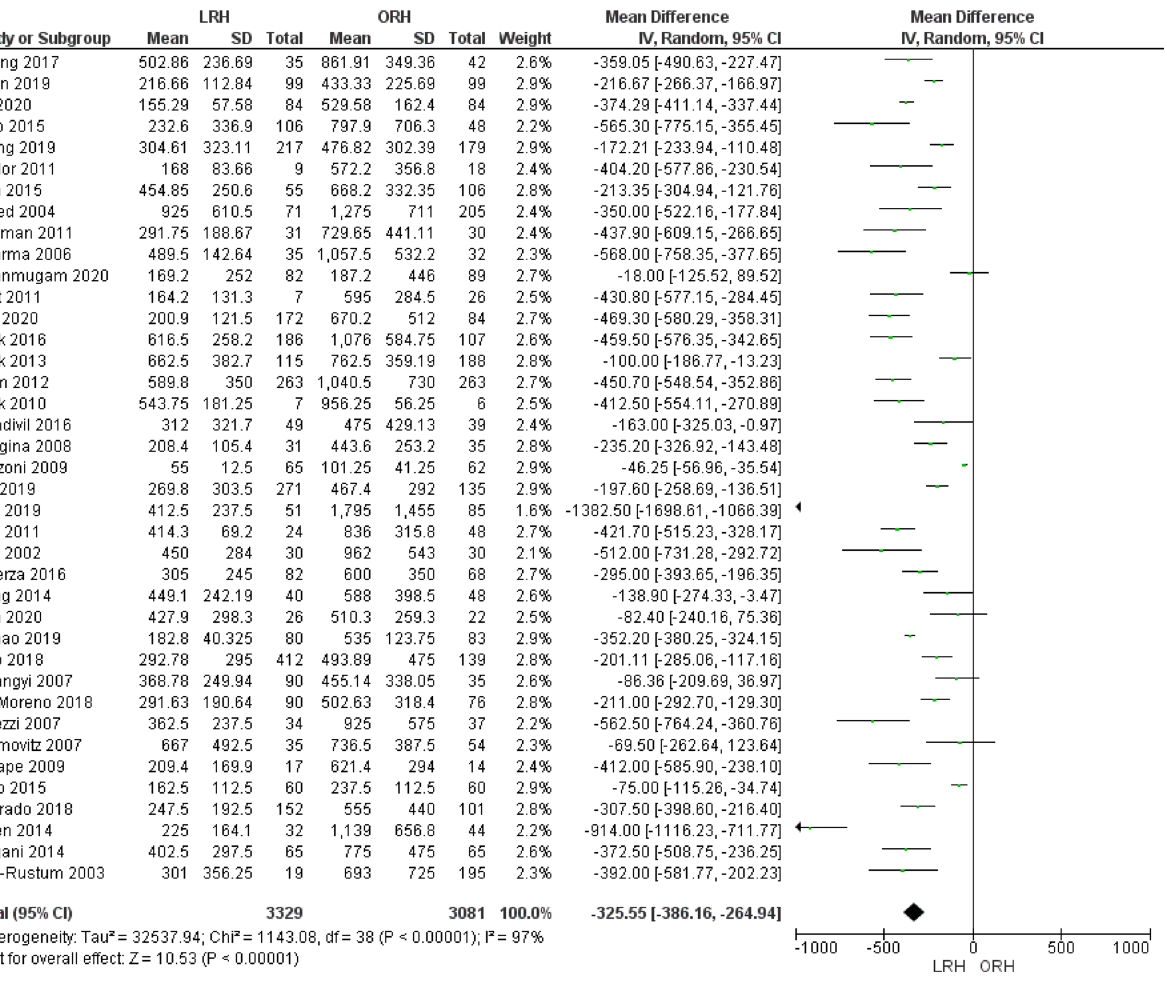
Figure 3. Forest plot of estimated blood loss